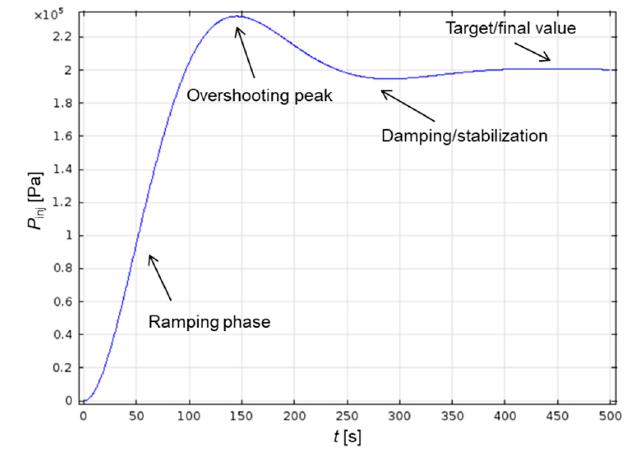
Figure 5. Variable function representing a time-varying injection pressure.